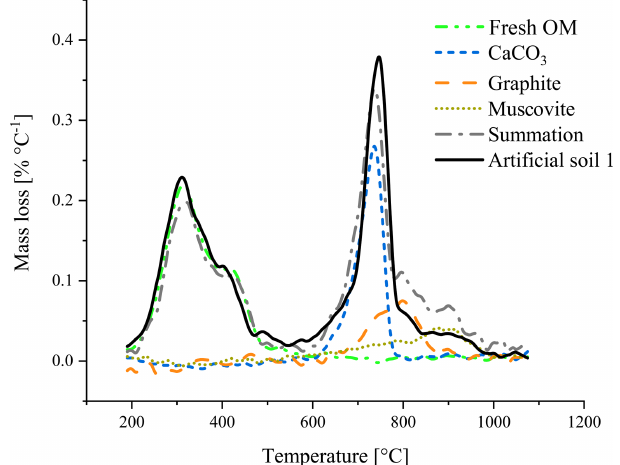
Figure 2. Thermogravimetric analysis of artificial soil 1 and its components measured individually. The summation (dash-dotted, grey) is the combined mass loss of the individual